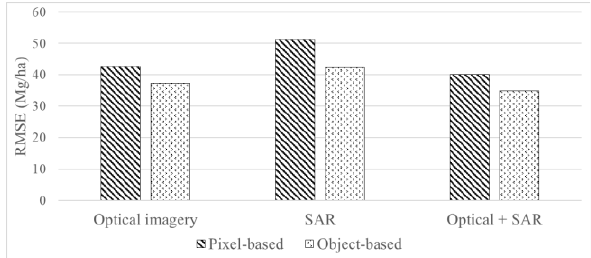
Figure 2 . Comparison the RMSEs of pixel-based and object- based approaches for optical, SAR, and optical + SAR